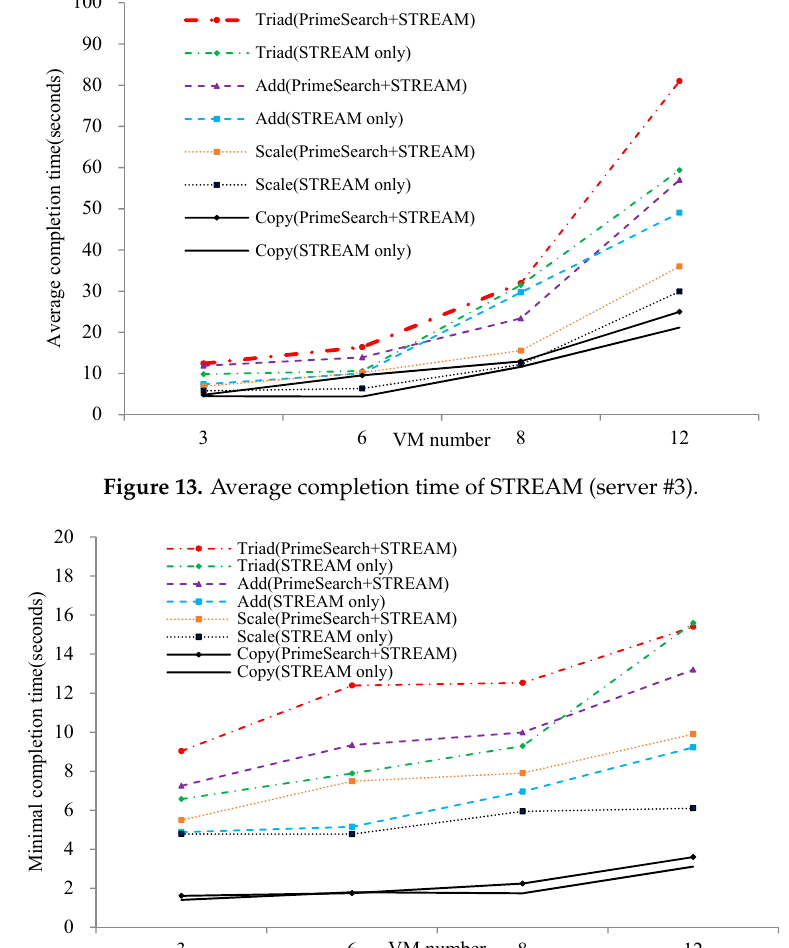
Figure 15. Maximum completion time of STREAM (server #3).